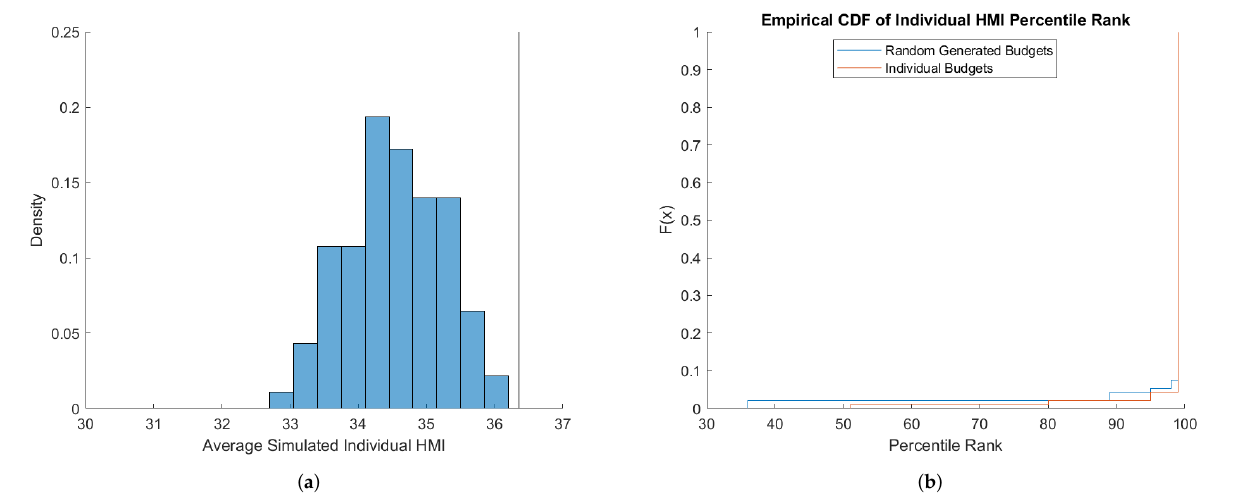
Figure 3. Simulation results for HMI (CFGK). ( a ) Histogram, ( b ) Percentile